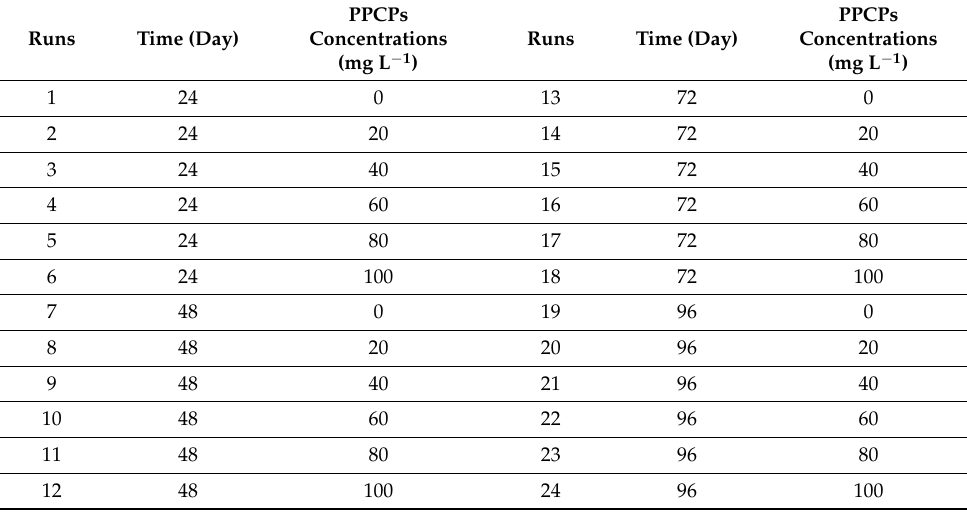
Table 5. Experiments for examining the effects of PPCPs on